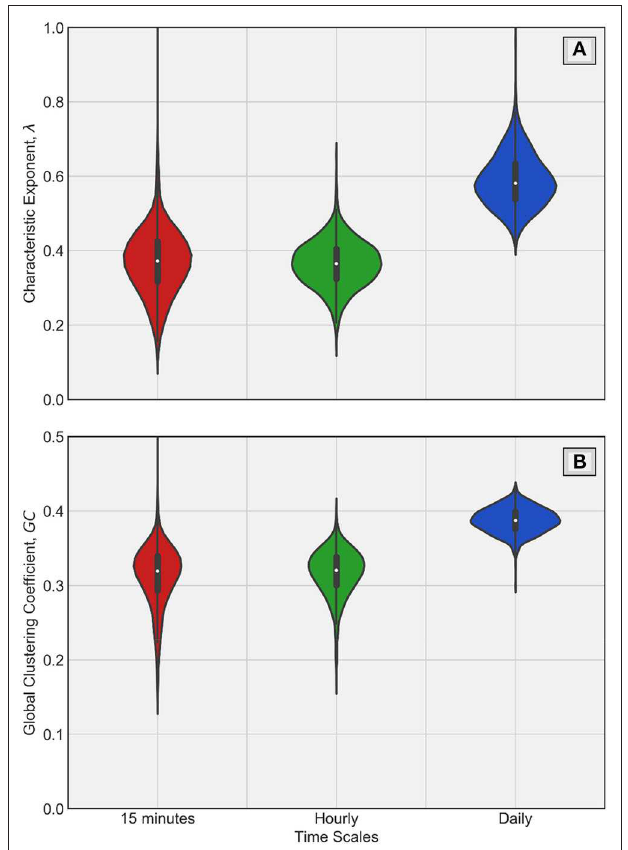
FIGURE 10 | Violin plots of λ and GC across time scales of streamflow time series in (A,B) , respectively. The solid white dot inside each violin represents median while the thicker solid line inside represents interquartile range (75th percentile − 25th percentile). Clearly, the daily time scales have higher λ and higher GC , indicating that averaging affects the dynamics (from chaotic at short time scales to stochastic at longer time scales).